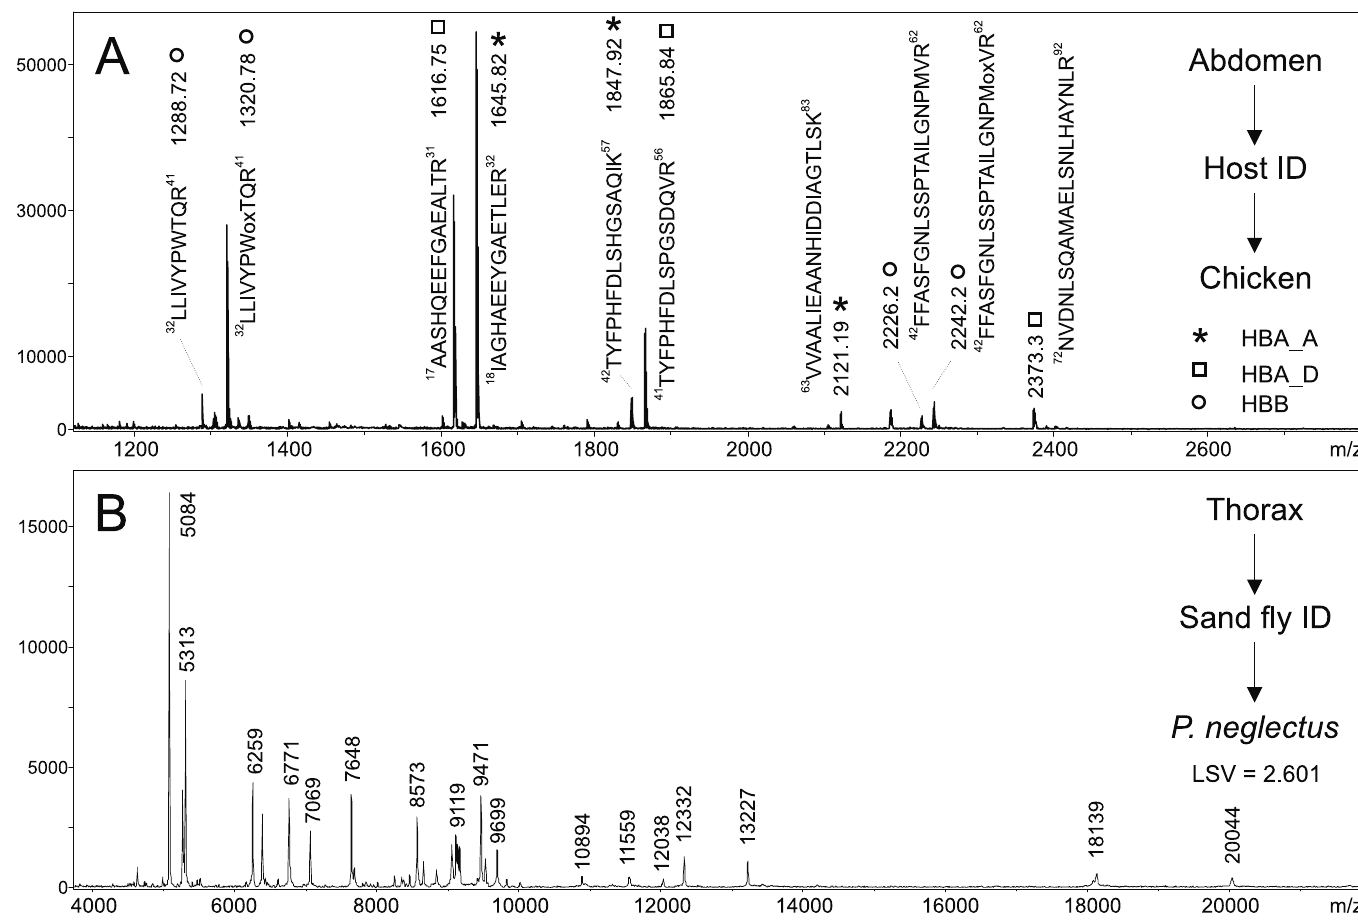
Fig 6. Parallel host blood and sand fly species identification from a single specimen. Blood meal source of the field-caught female EPO1 (see Table 3) was determined by PMM-based MALDI-TOF MS of trypsin-digested abdomen (A). The peaks in MALDI-TOF peptide mass map are labelled by amino acid sequences of chicken HBA (two allelic variants A and D) and HBB. Simultaneously, thorax of the specimen was utilized for sand fly species identification using MALDI-TOF protein profiling